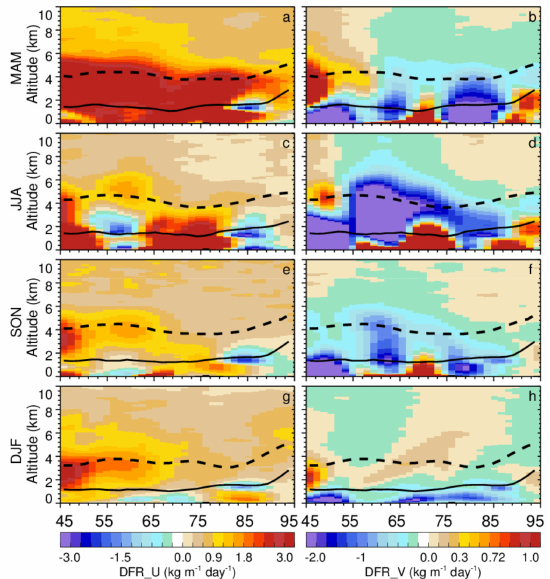
Figure 4. Seasonal longitude–height cross-section of DFRs derived from CALIOP at ( left panel ) zonal and ( right panel ) meridional directions in ( a , b ) spring (MAM: March–April–May), ( c , d ) summer (JJA: June–July–August), ( e , f ) autumn (SON: September–October–November), and ( g , h ) winter (DJF: December–January–February), averaged over the southern portion of the regions (25– − 40 ◦ N). The black lines indicate that 50% (solid line) and 90% (dashed line) of DMC lies below that height. Here the positive DFRs represent the dust transport eastward and northward.